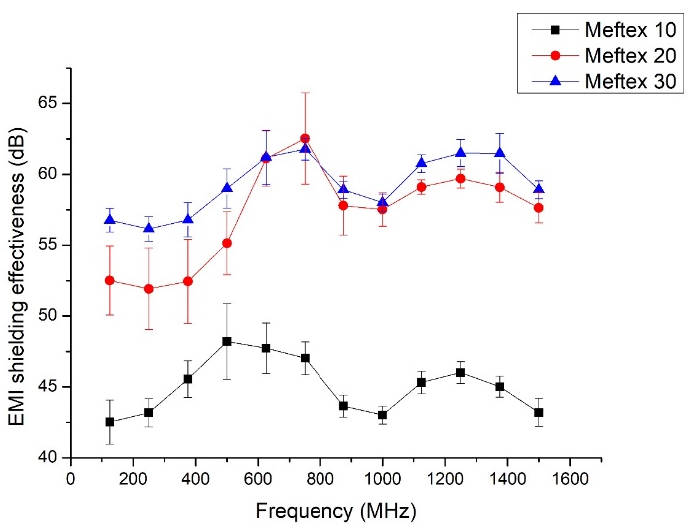
Figure 6. MEFTEX EMI shielding effectiveness in the frequency band from 30 MHz–1.5 GHz. For conductor plate shielding materials, SE can be calculated by the Schelkunoff equa- tion (Equation (4)) based on the transmission theory, with SE A [dB] being the absorbing loss of the shielding materials, SE R [dB] the single reflection loss on the surface of the shielding materials, and SE M [dB] the multi-reflection loss inside the shielding materials